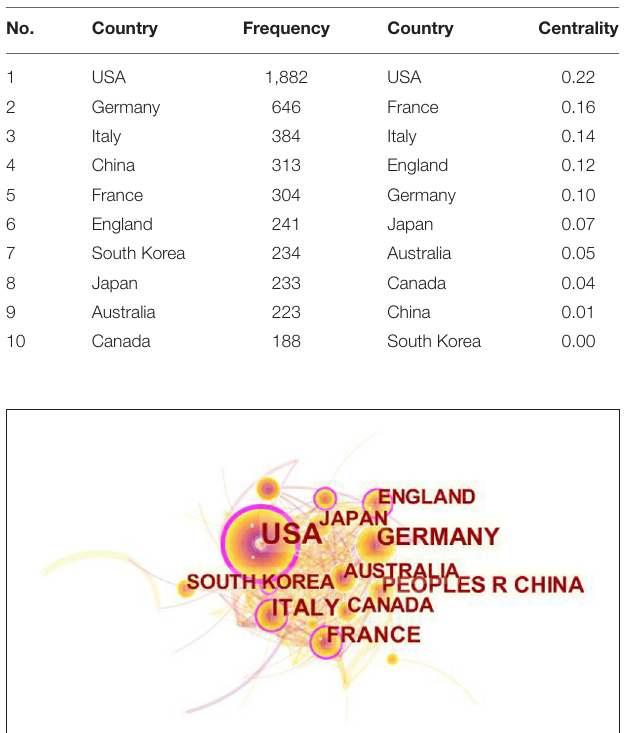
FIGURE 2 | Annual publications. TABLE 2 | Top 10 countries by publication frequency and centrality.